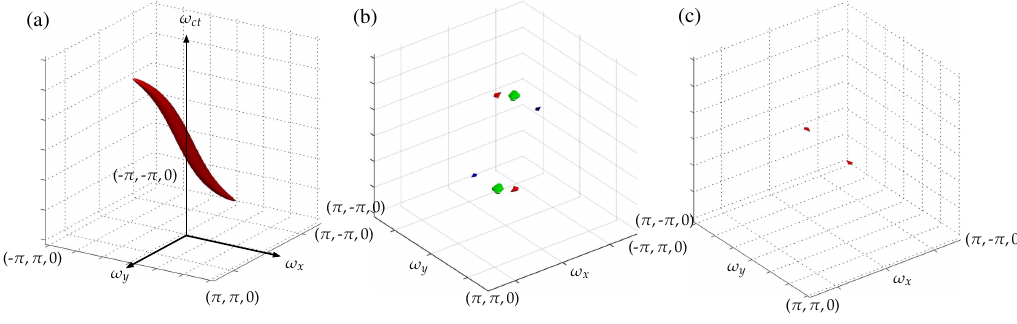
Figure 8. ( a ) Frequency response of the 3D IIR beam filter in ( x , y , ct ) 3D space-time domain and directional enhancement of plane wave signals using the 3D IIR beam filter; ( b ) input signal and ( c ) filtered signal.